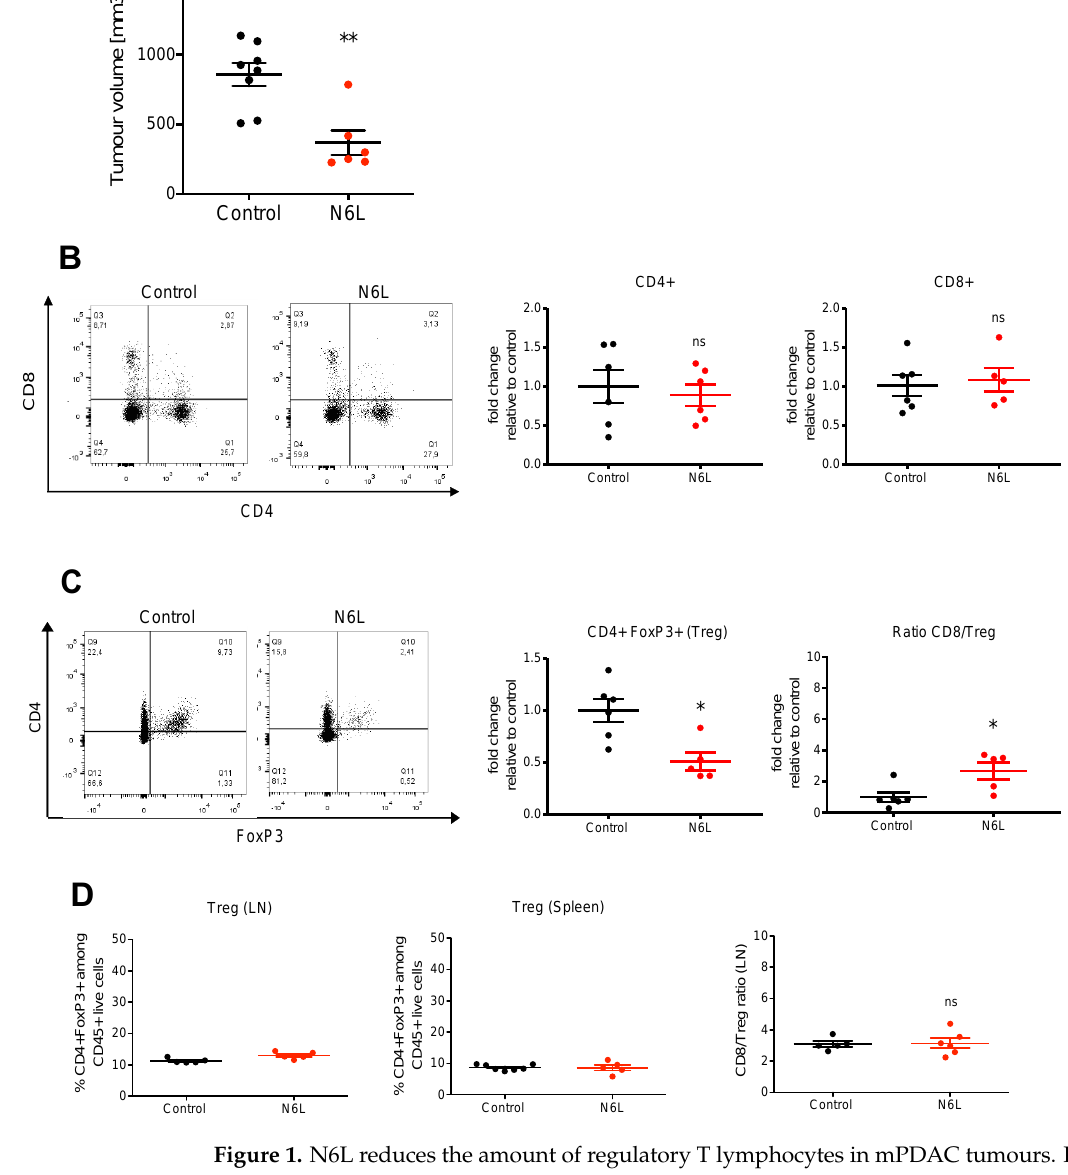
Figure 1. N6L reduces the amount of regulatory T lymphocytes in mPDAC tumours. Immunocom- petent syngenic FVB/n mice were injected with mPDAC cells into the pancreas. Mice were treated one week after cell inoculation with N6L (7 mg/kg) or saline solution by i.p. injections three times a week for three weeks. ( A ) Mice were sacrificed, and tumour volumes were measured. Graph shows a representative experiment (from three independent experiments). ( B , C ) CD4 + , CD8 + T lymphocytes and regulatory T lymphocytes (Tregs) from tumour tissues were analysed by flow cytometry among the CD45 + cells, and the fold change of the % of CD45 + CD4 + , CD45 + CD8 + , or CD45 + CD4 + FoxP3 + cells of N6L-treated tumours relative to the control are plotted in the graphs. Graphs show the fold changes of three experiments. ( D ) The graphs show the % of CD45 + CD4 + FoxP3 + of control and N6L-treated mice in lymph nodes and in spleen of mice of the representative experiment in ( A ), and the CD8/Treg ratio in lymph nodes. In A (Control n = 8 mice, N6L n = 6 mice) and in B, C and D the sample number is indicated on the graphs and depends on the efficiency of cell isolation and flow cytometer analysis. p -values were calculated between indi- cated conditions by the two-tailed Mann-Whitney U-test (**, p < 0.01; *, p < 0.05; ns = not significant).